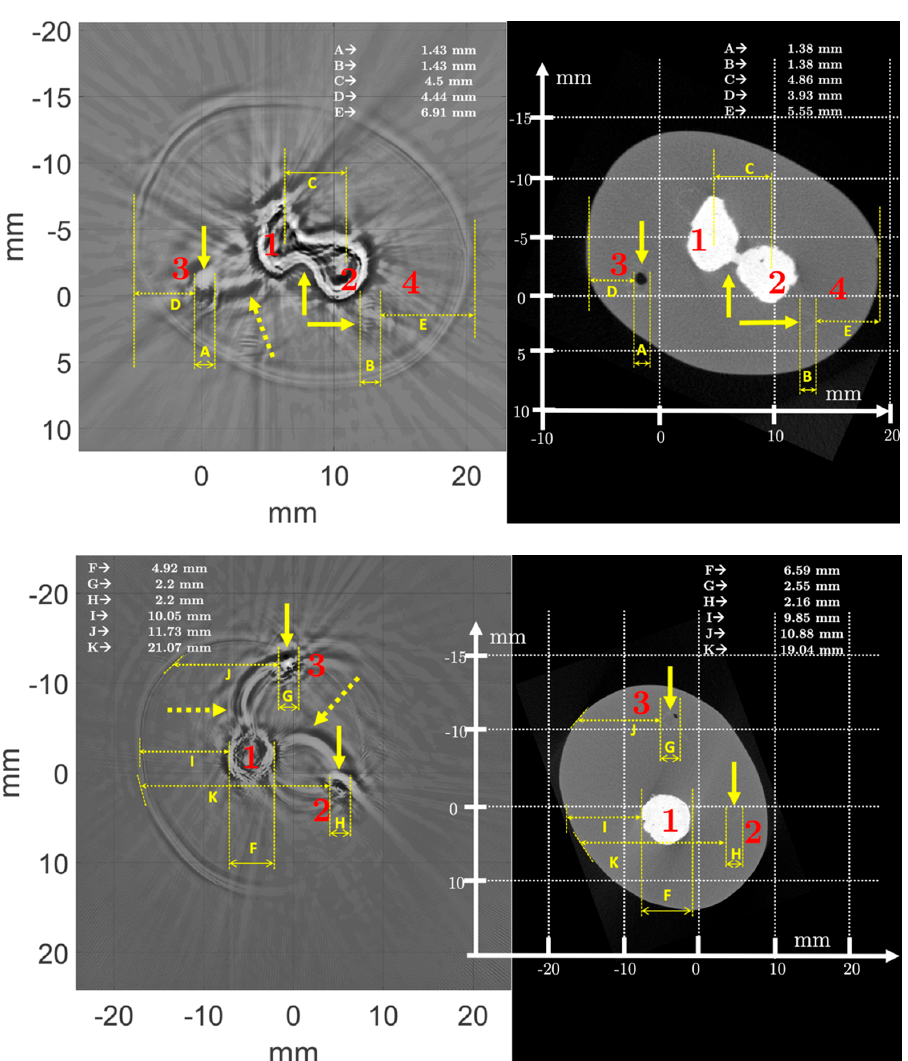
Figure 13. Morphometric analysis of the newborn arm phantom (True Phantom Solutions) by comparing USCT and μ CT. Solid arrows indicate areas of blood vessels and bones. Dotted arrows show artifacts.